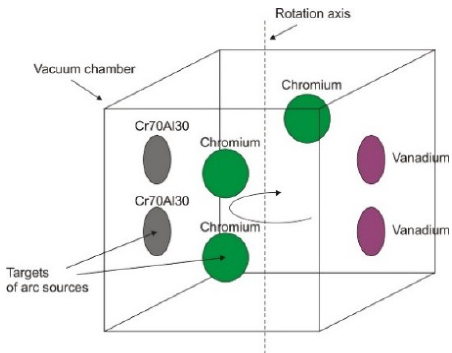
Figure 1. Schematic presentation of location of Cr, V and Cr70Al30 targets within the vacuum chamber of the arc deposition system .